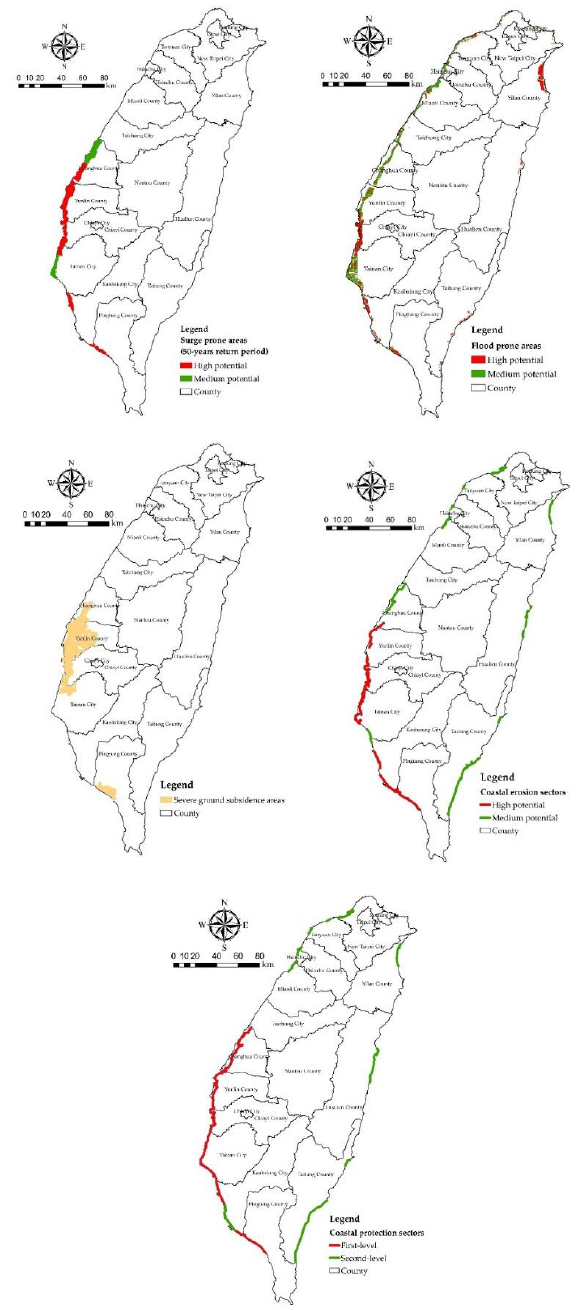
Figure 1. Distribution of hazard prone areas, and first- and second-level coastal protection areas.